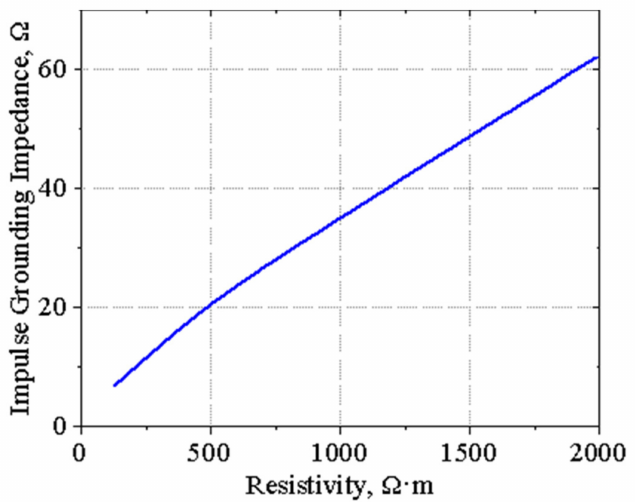
Figure 6. Influence of the resistivity on the impulse grounding impedance of a vertical rod of 10 m, critical electric field of 10 kV/cm, current peak of 50 kA and waveform of 0.25/100 µ s. The surge as lightning can take different peak values, according to the IEC 62305